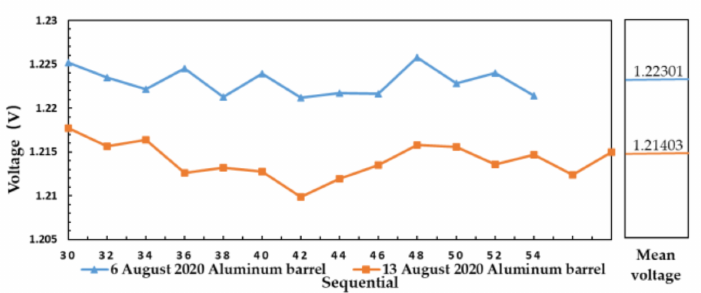
Figure 18. The measurement result of aluminum plate with different temperature in different days.